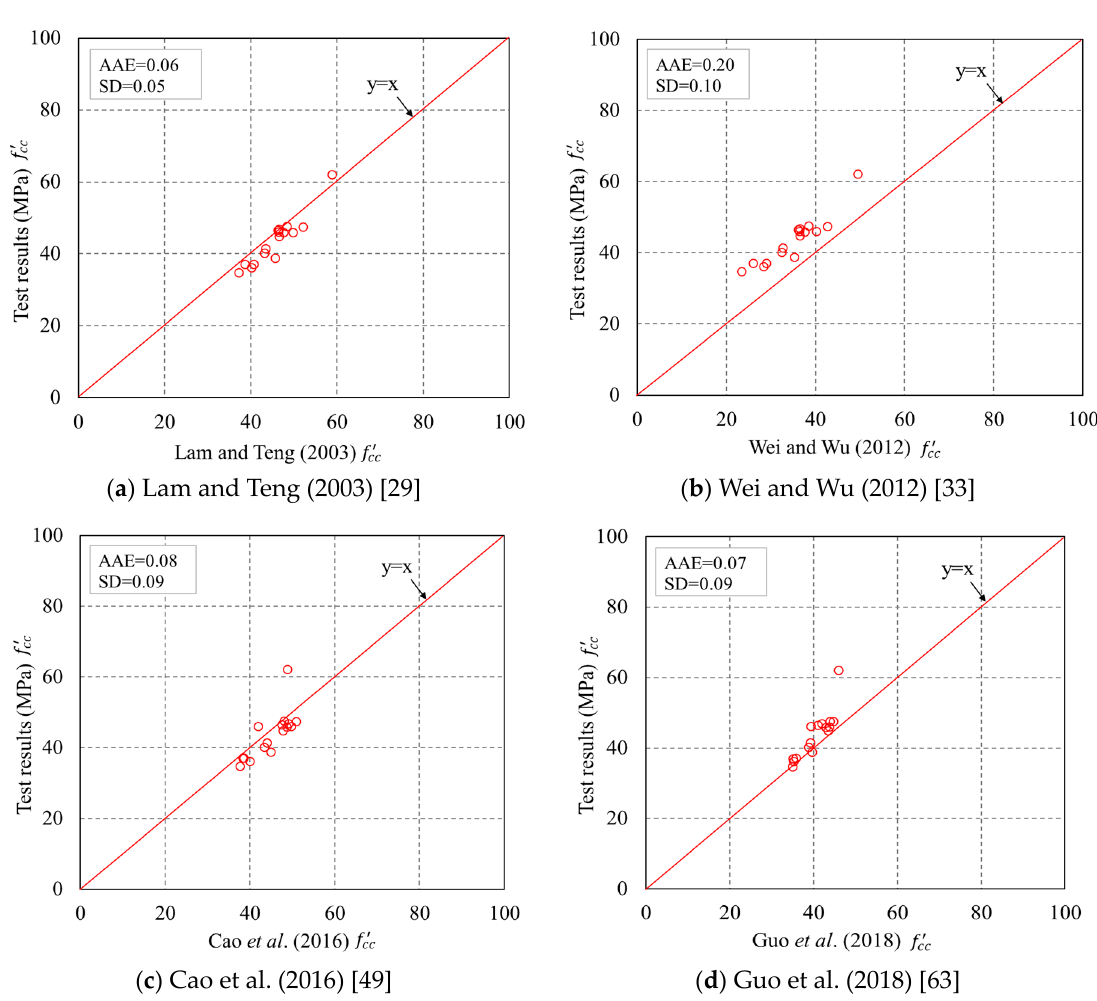
Figure 16. Performance of the existing models in predicting the ultimate axial stresses. AAE = average absolute error. SD = standard deviation.